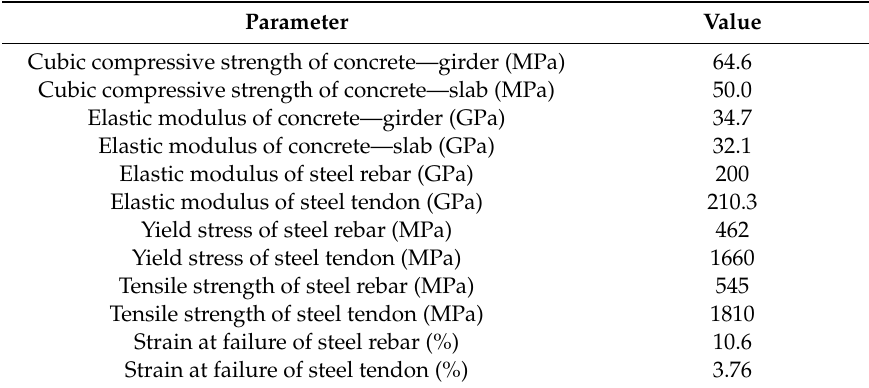
Table 3. Mechanical properties of concrete, longitudinal steel rebar and tendons [33].